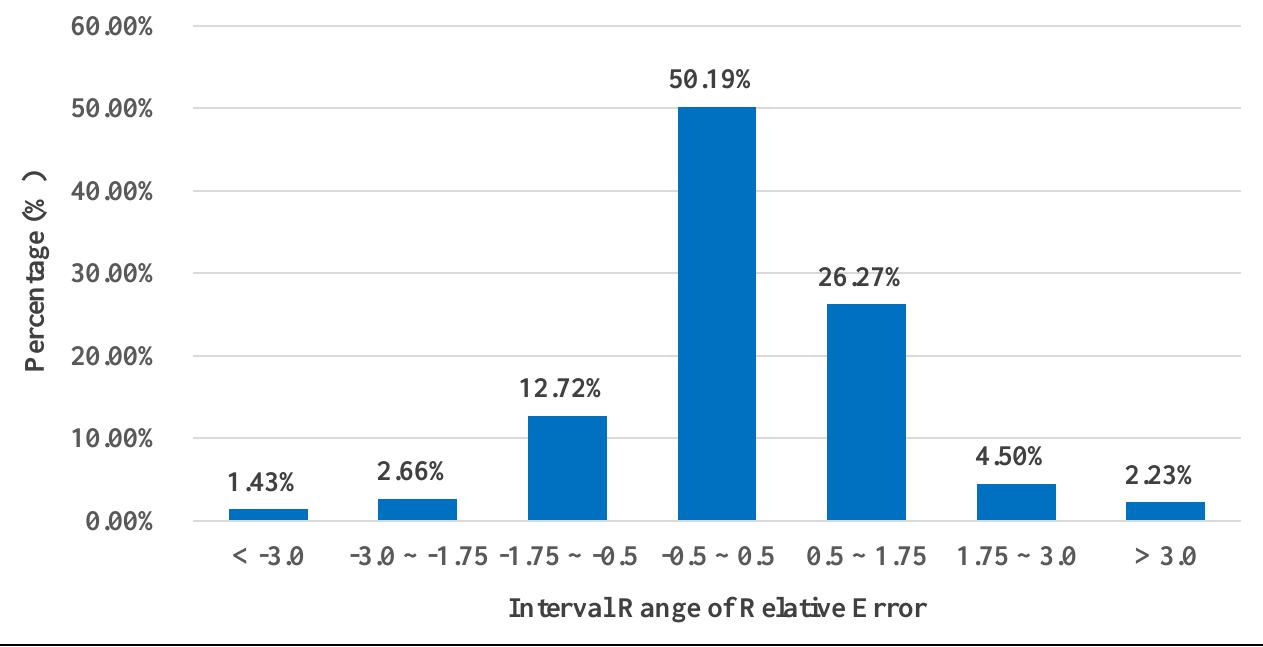
Figure 10. Ratio of the interval range of the relative error between actual and predicted FAR.